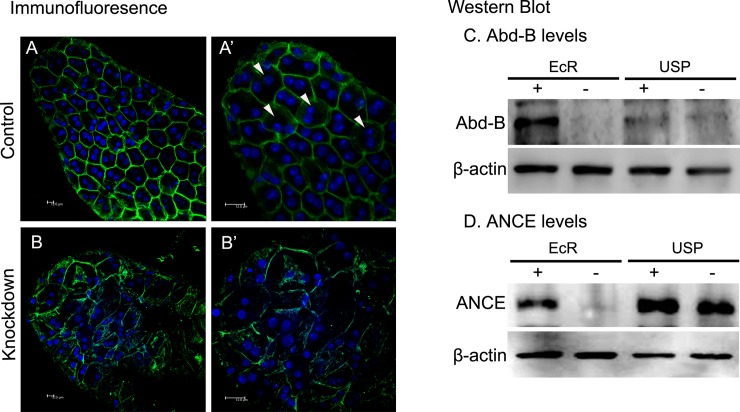
The effect of EcR knockdown on the cellular organization of the accessory glands.Immunofluorescence panels shown here are the overlay images of accessory glands immunostained with α-Spectrin antibody (marking cell membrane, Green color) and labeled with nuclear stain DAPI (blue color). In EcR control glands, several polygonally shaped binucleate cells (the main cells) and a few large and spherical binucleate cells (the secondary cells, marked with arrow) interspersed between the polygonally shaped cells were observed at 400X (Panel A) and at a higher magnification of 630X (Panel A′). However, in EcR-deficient glands, cell membranes are highly disrupted (Panel B at 400X) and the nuclear distribution is distinctly different from that of control (Panel B′ at a total magnification of 630X). To assess the effect of depletion of EcR or USP, in accessory glands,western blots were probed for the secondary cell markers, Abd-B and ANCE. The glands lacked Abd-B (Panel C,—lane under EcR in Abd-B blot) while EcR control (Panel C, + lane under EcR), USP control (Panel C, + lane under USP) or USP knockdown (Panel C, -lane under USP) had detectable levels of Abd-B. In addition, EcR knockdown glands did not contain ANCE (Panel D, -lane under EcR in ANCE blot) while the same could be detected in controls, suggesting the disruption of secondary cells due to depletion of EcR.